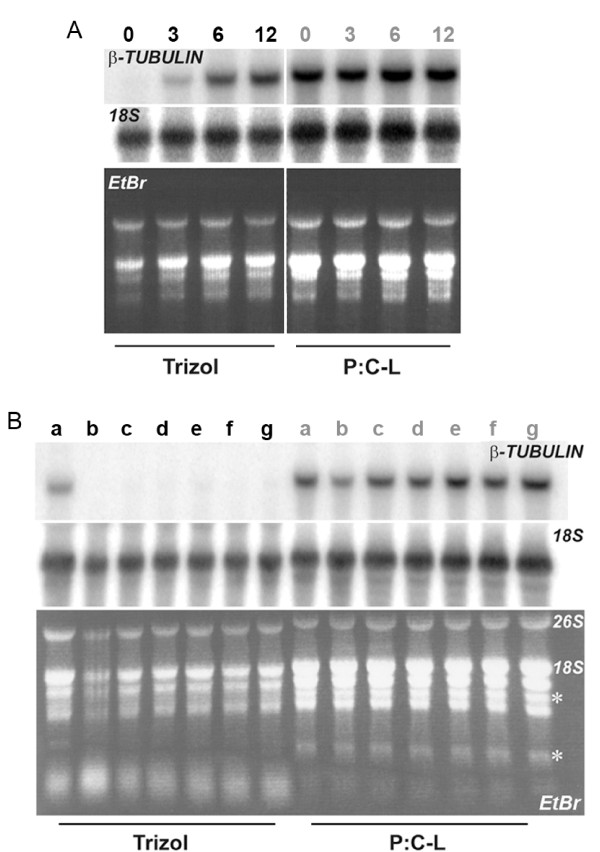
TRIZOL is not suitable for extracting RNA from very young tissues. RNA extracted using TRIZOL can satisfactorily isolate total RNA (18S bands) but very little mRNA (β-TUBULIN bands) is extracted from the very youngest Arabidopsis tissues. This bias is not evident in RNA prepared from the same tissue using P:C-L extraction. (A). Northern blot of TRIZOL and P:C-L-extracted RNA (10 μg) from samples grown for zero, three, six, or 12 days prior to a six week cold treatment and harvested in the cold. As the age of the seedlings increase, β-TUBULIN expression rises as a proportion of total RNA in the TRIZOL-extracted RNA preparations. By the time tissue was 12 days old, the bias observed in TRIZOL-extracted RNA had diminished. This effect is also observed for FLC (data not shown). (B). Northern blot comparing TRIZOL and P:C-L-extracted RNA (10 μg) of non cold treated five-day old (i.e. just germinated) Arabidopsis seedlings from several different genotypes (a-g) shows that the age-related bias observed in TRIZOL-extracted RNA is highly repeatable and not subject to growth conditions. TRIZOL and P:C-L extracted RNA preparations appear to differ significantly in the population of major RNA species visible by agarose gel electrophoresis (asterisks).